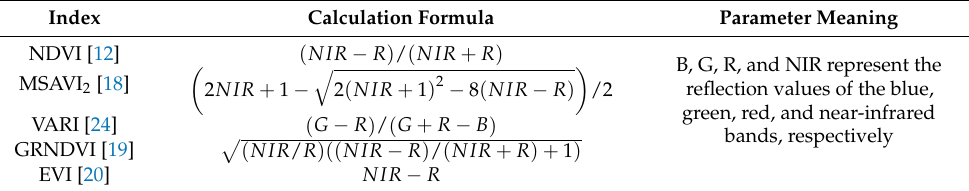
Table 2. The vegetation index formula is tested in the